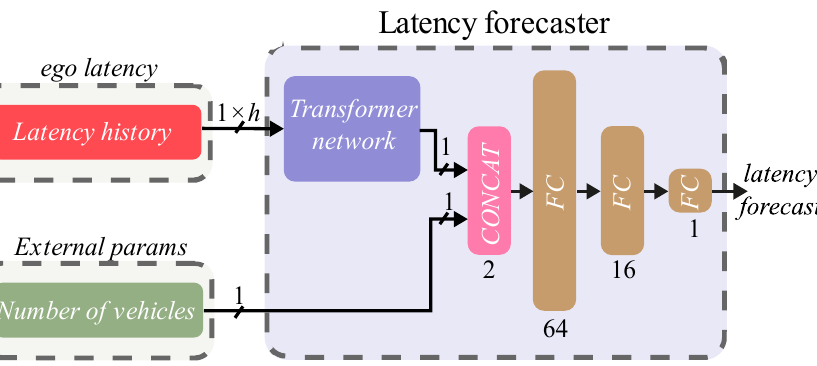
Figure 4. The architecture of the latency forecast module is composed of a transformer network and 3 fully connected layers. The size of the transformer network input depends on the size of the con- sidered window ( h ), which controls how many previous latencies are considered when predicting. The output of the transformer network is concatenated with the variable of the number of simulated vehicles (to be controlled) and fed into the fully connected layer